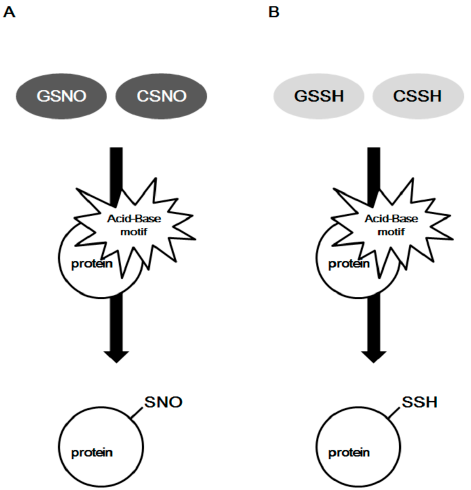
Figure 4. The forming mechanisms of protein S-nitrosylation and S-sulfhydration by physiological relevant donors. CSNO, nitrosocystiene; CSSH, cysteine persulfide; GSNO, nitrosoglutathione; GSSH, glutathione persulfide.